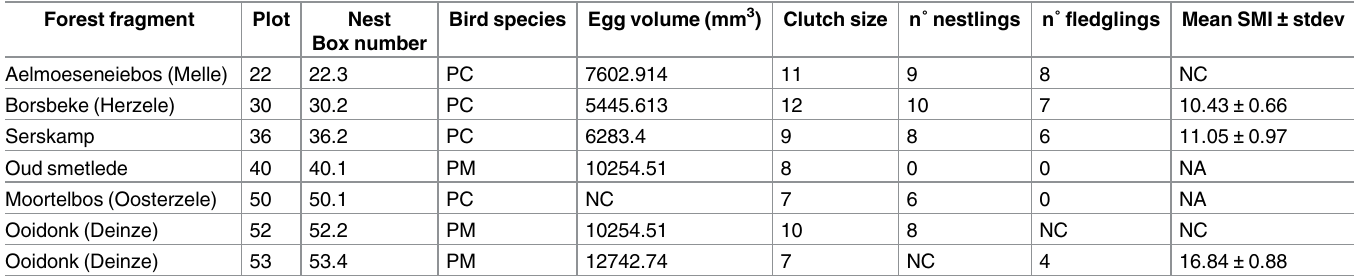
Shown is the egg volume of the Salmonella positive eggs of blue (PC) and great (PM) tits, found in 53 analyzed plots. Per positive nest box, the clutch size, number of nestlings, number of fledglings and the brood reduction (number of nestlings–number of fledglings) are given, as well as the mean scaled-mass index (SMI) ± stdev of the nestlings. Due to practical issues, some samples were not collected (NC). If the number of fledglings was equal to 0, brood reduction and SMI could not be calculated (not applicableor NA).